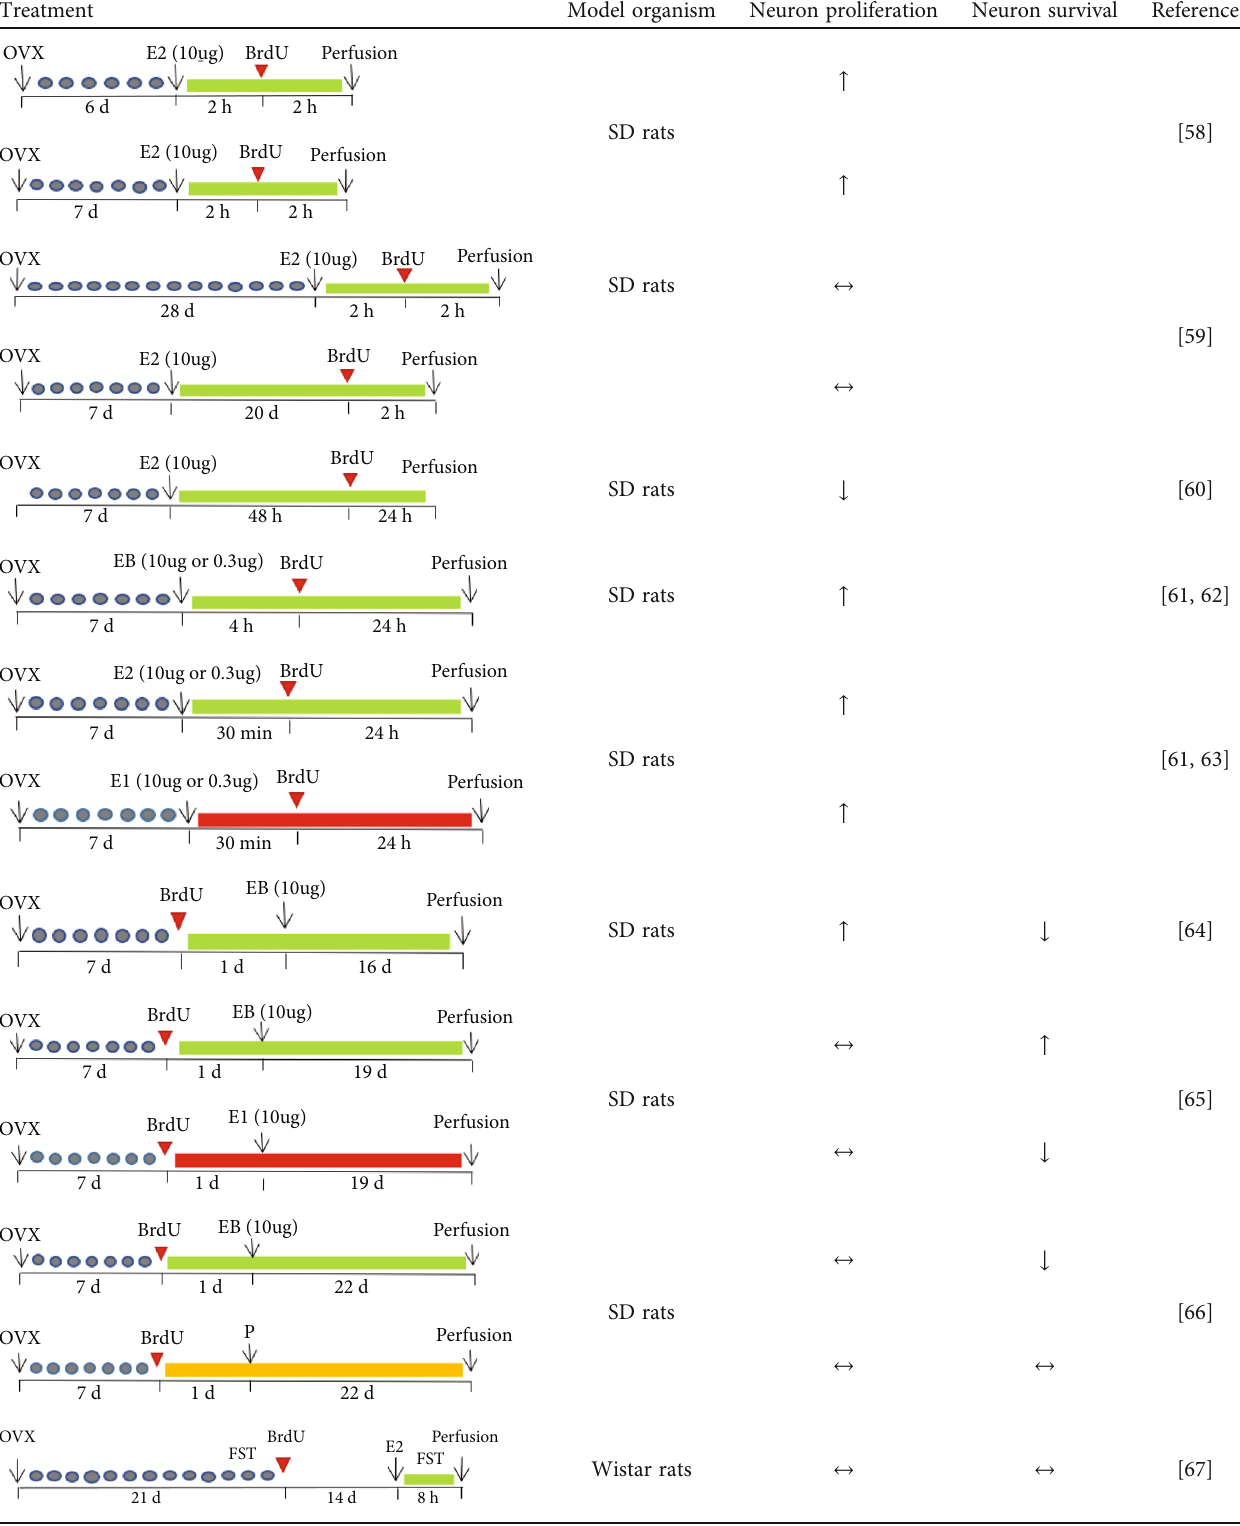
Table 1: E ff ects of di ff erent estrogen and progesterone treatments on the adult hippocampal neurogenesis of mammals.